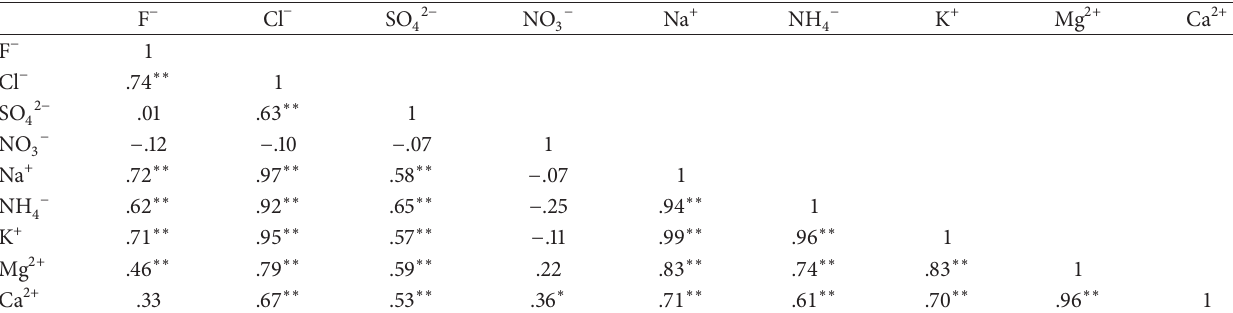
Table 2: Pearson correlation matrix among some major ions in the water samples from Bagmati drainage system within Kathmandu